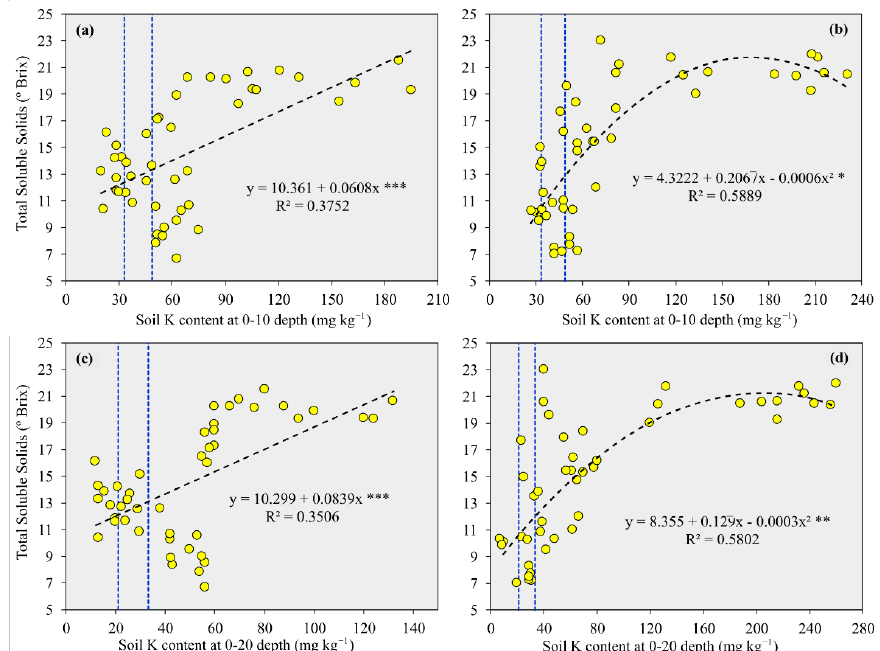
Figure 7. The relationship between the soil K content and the total soluble solids (TTS), in the evaluated crops seasons, in ‘Chardonnay’ ( a , c ) and ‘Pinot Noir’ ( b , d ). Vertical blue dotted lines represent the range of probability of occurrence (95% highest density interval) of the CL of K. The black dotted line is the behavior of the equation (TSS variable). “*” Significant at 5% ( p < 0.05). “**” Significant at 1% ( p < 0.01). “***” Significant at 0.1% ( p < 0.001).